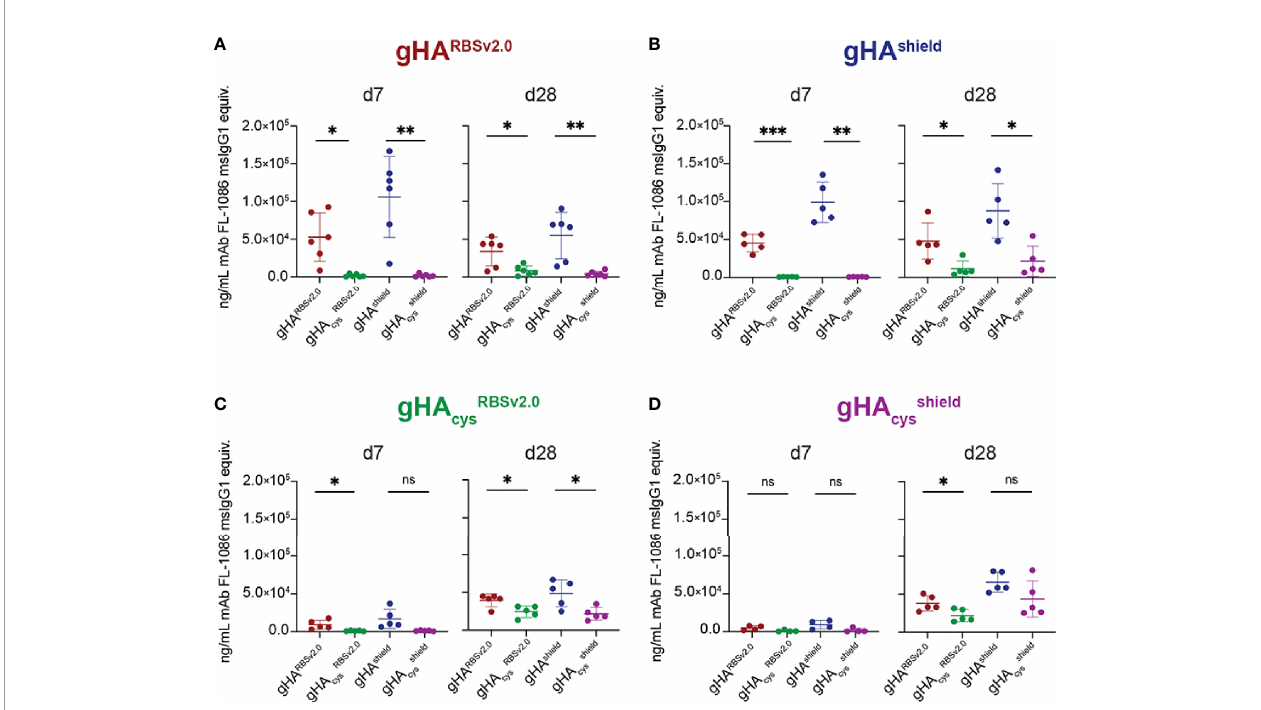
FIGURE 3 | gHA immunogens elicit cross-immunogen reactivity. Plot titles indicate immunogen and x-axis indicates Luminex antigen. At day 7 (d7), gHA RBSv2.0 (n=6) (A) and gHA Shield (n=5) (B) immunogens elicit interface-directed serum responses, while the cysteine-stabilized counterpart immunogens (C, D) elicit a nearly undetectable serum response. By day 28 (d28, right), cysteine-stabilized gHA cysRBSv2.0 (n=5) (C) and gHA cysshield (n=5) (D) immunogens elicit a weak, but present serum response to all immunogens. All serum responses are normalized to a control antibody, FL-1086, that binds all four immunogens, and reported as ng/mL FL- 1086 msIgG1 equivalents ± SD; n = number of mice used. Statistical signi fi cance was determined by a student ’ s t-test with Welch ’ s correction. (*P < 0.05; **P < 0.01; ***P < 0.001; ns, not signi fi